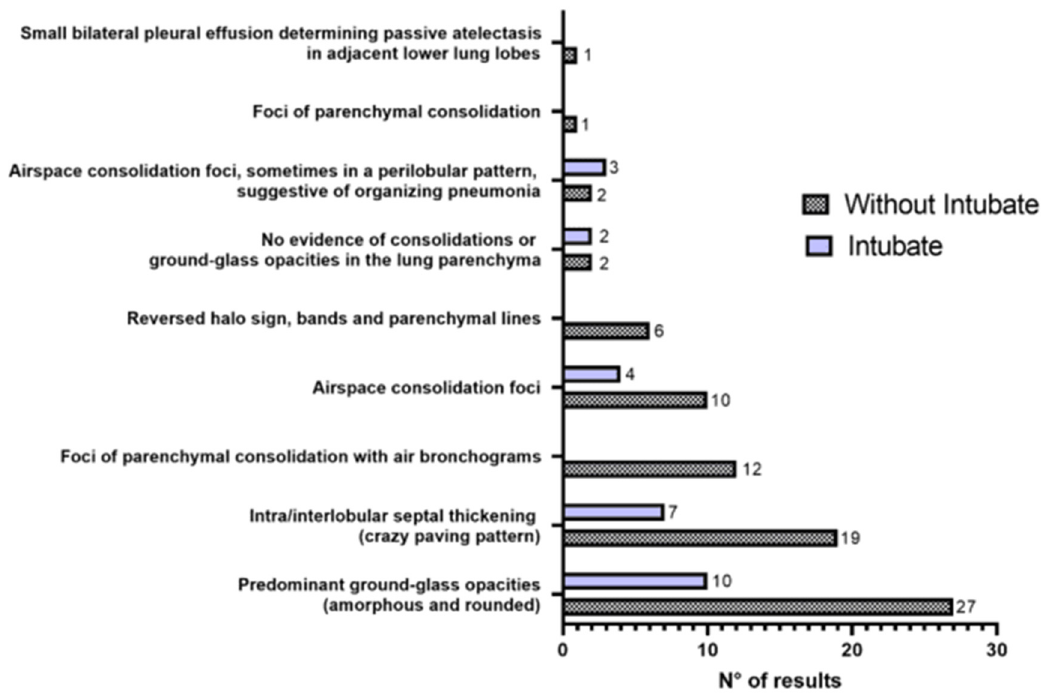
Figure 6. Main pulmonary findings on imaging exams (computed tomography and chest X-ray) considering the patients who needed or who did not need mechanical ventilation.